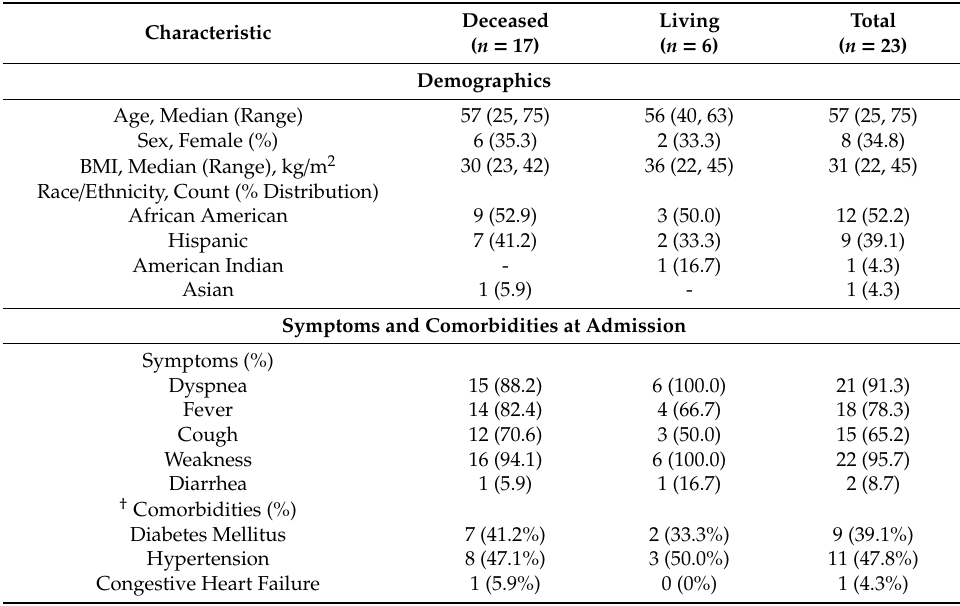
Table 1. Clinical characteristics, lung infiltrate severity, and pronation timeline by living